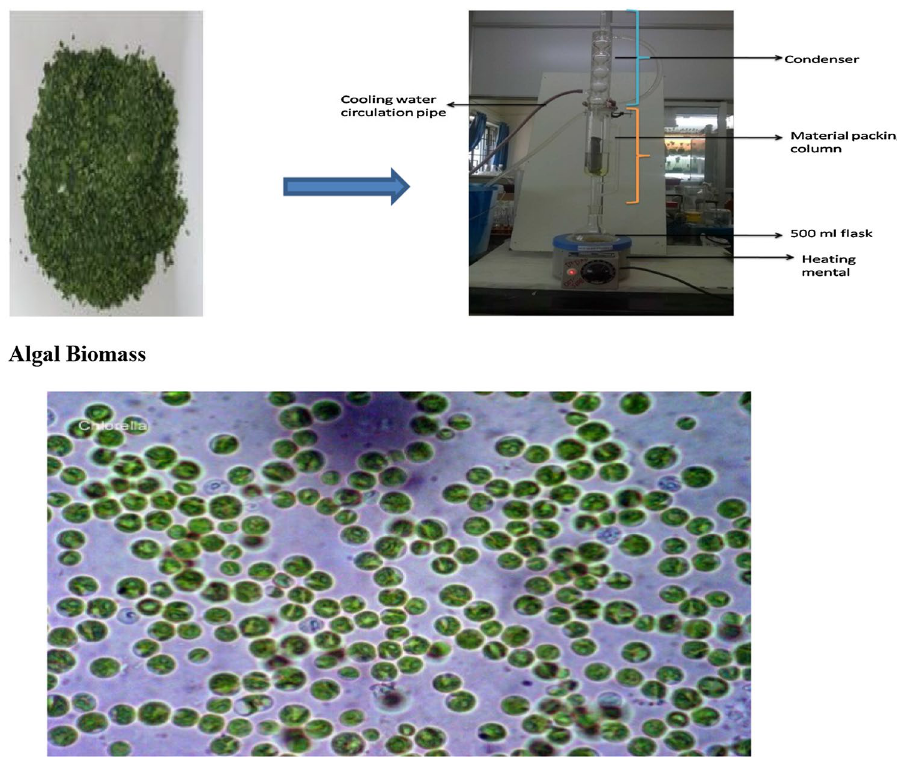
Fig. 1 Extraction of hydrocar- bons. a Heating under reflux method and b microscopic image of Chlorella pyrenoidosa (×